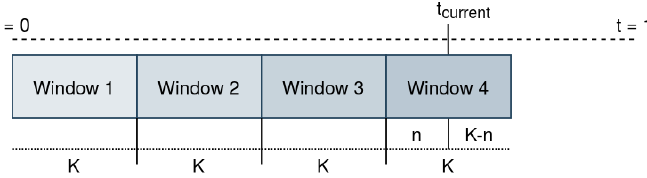
Figure 3. The bid windows that split the negotiation history into partitions of K bids.